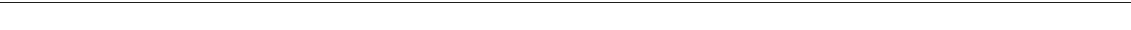
Fig. 8 UBR5 determines HD-iPSC differentiation into NPCs with no aggregates. a qPCR of pluripotency ( OCT4 , NANOG , SOX2 , DPPA4 ), endodermal ( GATA6 , AFP ), mesodermal ( MSX1 ) and ectodermal markers ( PAX6 , NES ) in HD Q71-iPSC line #1. The graph represents the relative expression to NT shRNA HD-iPSCs (mean ± s.e.m. ( n = four independent experiments)). b Immunocytochemistry of HD Q71-iPSC line #1. OCT4 and